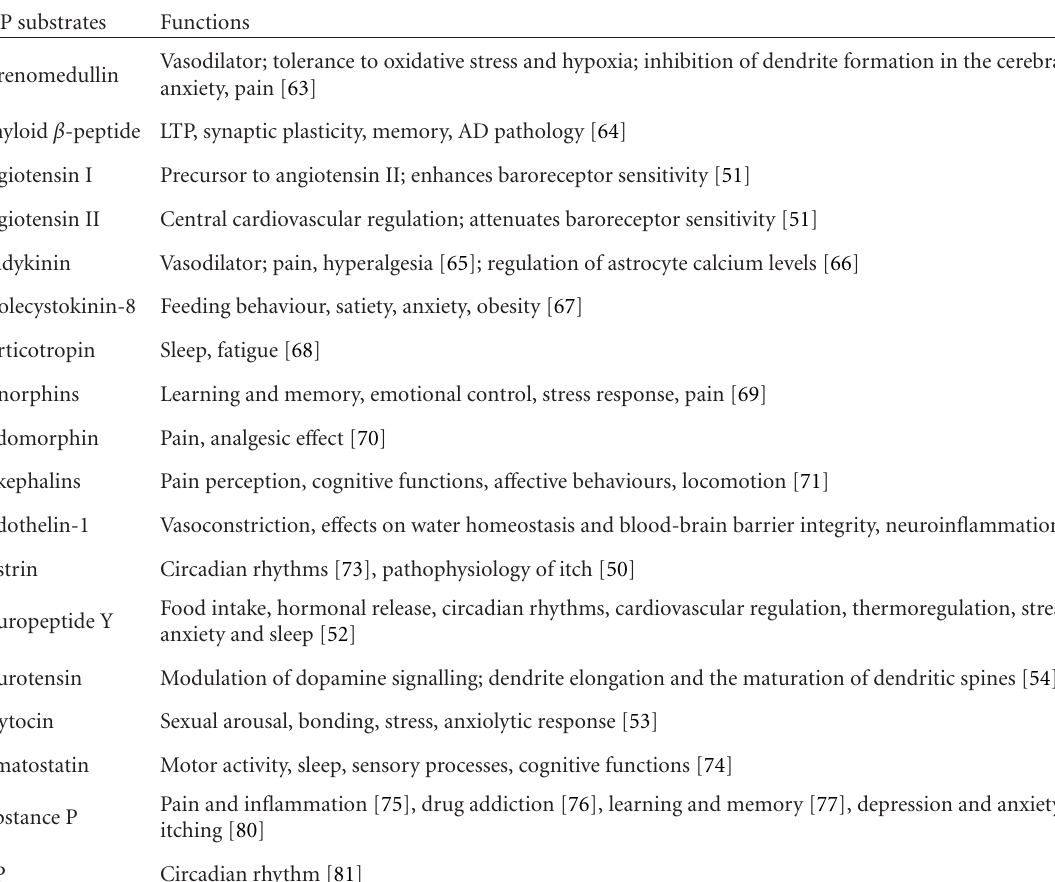
Table 1: Functional role of NEP and some of its substrates in the